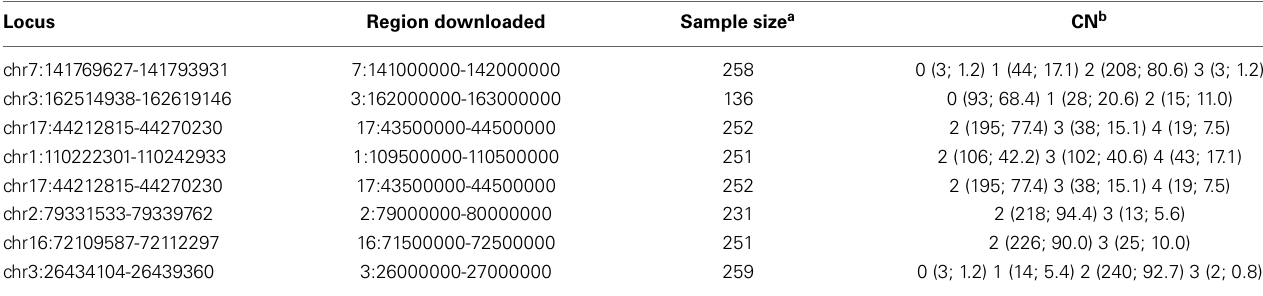
Table 3 | Eight loci which were obtained from the intersection of results of Conrad et al. (2010) and Campbell et al. (2011) were used to obtain parameters for CNVrd2 and to compare between CNVrd2 and